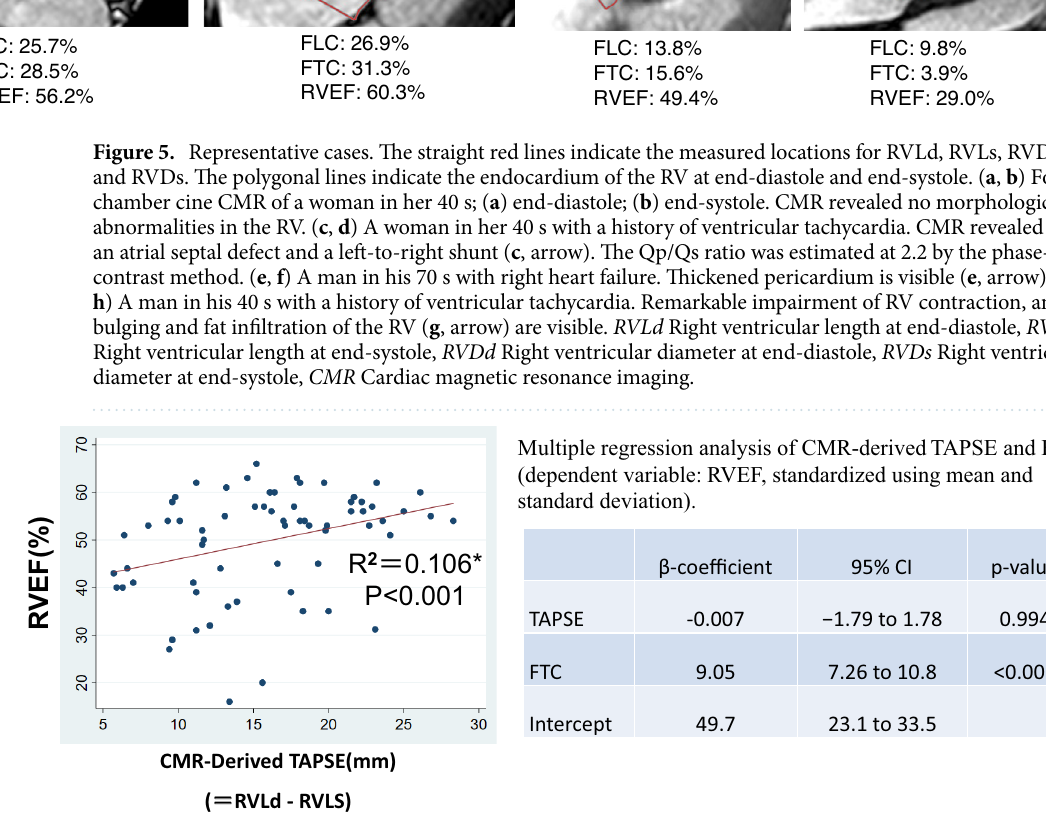
Figure 6. Scatter plots and linear regression lines for CMR-derived TAPSE, versus RVEF. CMR-derived TAPSE was defined as RVLd-RVLs. *Univariate linear regression analysis. The results of the multiple linear regression analysis are shown in the right side. In univariate regression analysis, CMR-derived TAPSE showed a weak correlation to RVEF. And it failed to show a significant correlation in a multiple regression analysis with the FTC. TAPSE Tricuspid annular plane systolic excursion, RVLd Right ventricular length at end-diastole, RVLs Right ventricular length at end-systole, CMR Cardiac magnetic resonance